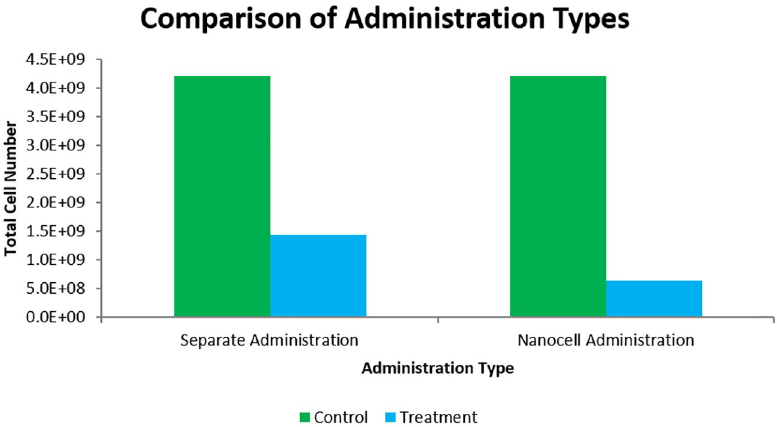
Fig 9. Comparison of optimal separate administration sequence vs. nanocell administration. Treatment schedules are as shown in Fig 7. Notice the improvement in cell kill in the nanocell